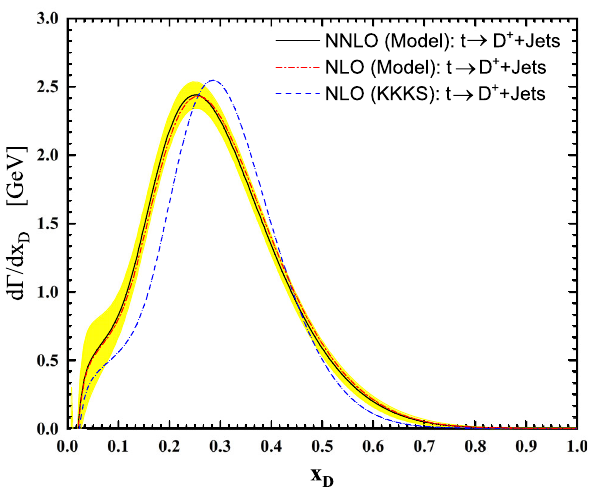
Fig. 6 As in Fig. 5, but for the D +